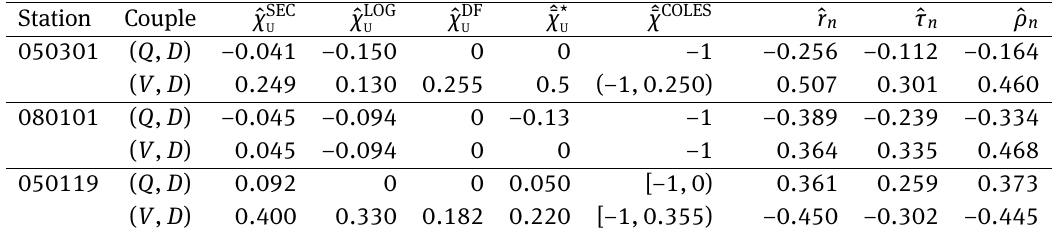
Table 4: Estimated tail dependence parameters ˆ χ SEC overall correlation coefficients ˆ r n , ˆ τ n and ˆ ρ n